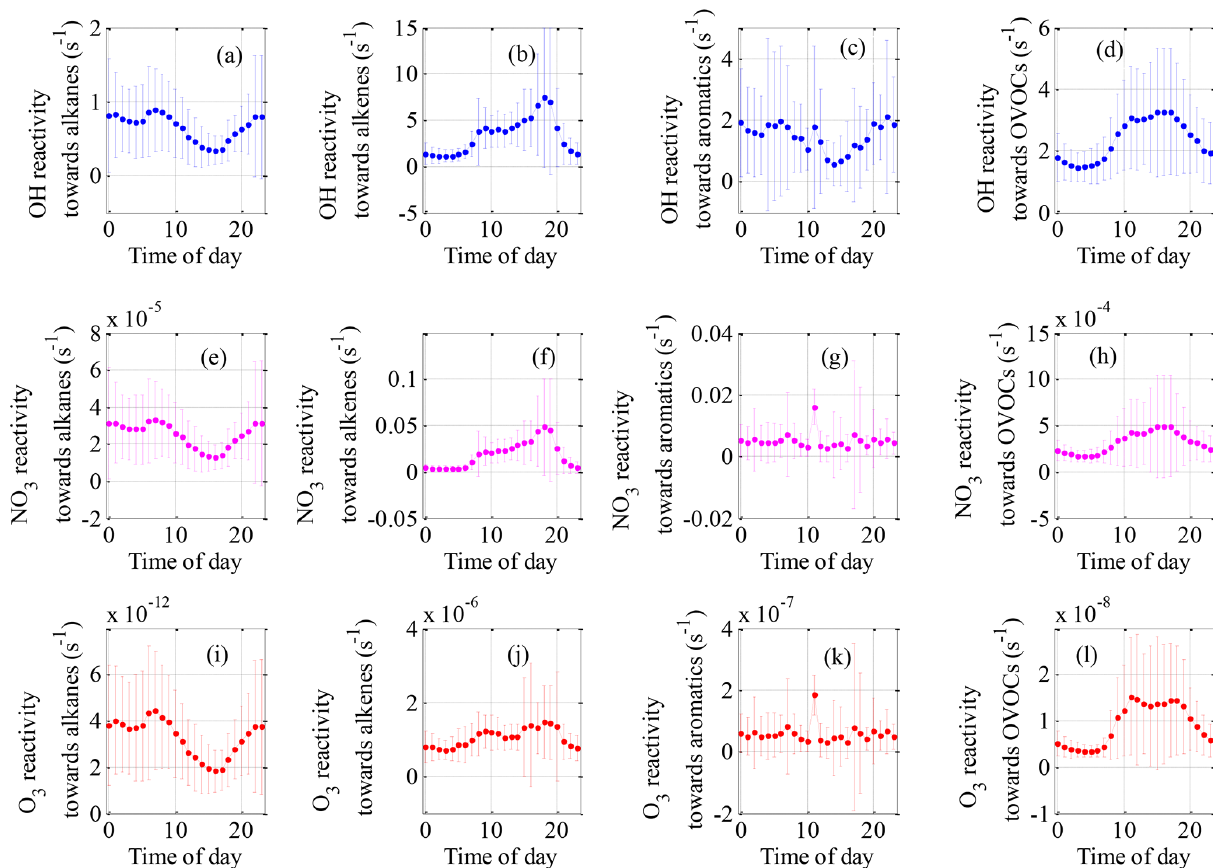
Figure 6. Mean diurnal variations in OH reactivity (a–d) , NO 3 reactivity (e–h) and O 3 reactivity (i–l) of NMVOC groups during the field campaign at Xianghe from 6 July to 6 August